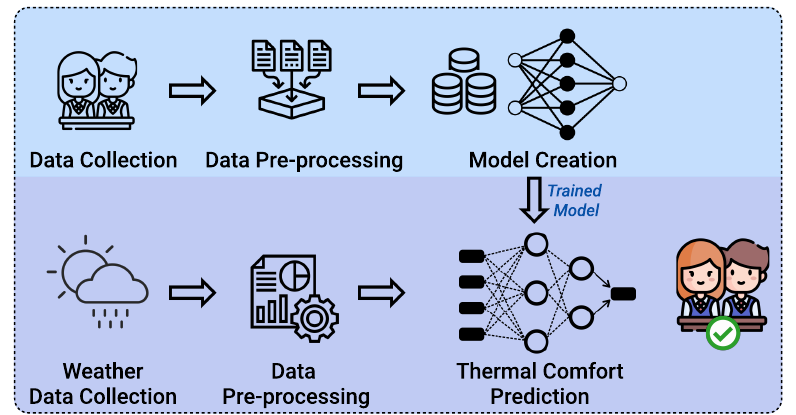
Figure 6. System architecture for machine learning-based TC